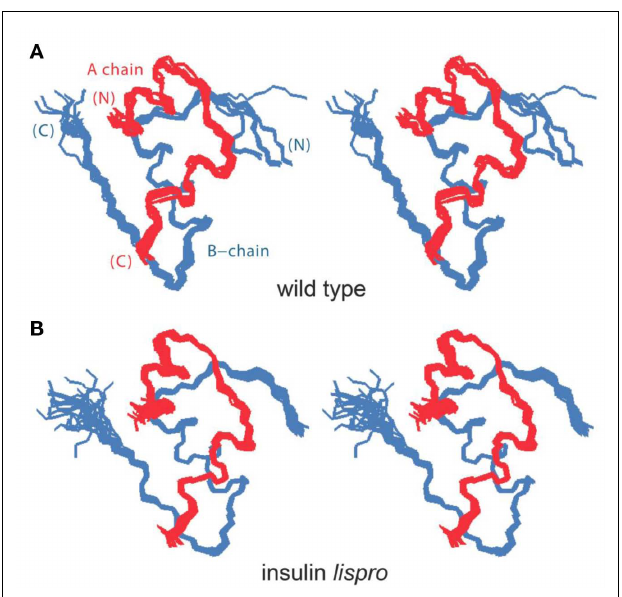
FIGURE 4 | NMR-derived structure of KP-insulin. (A) Reference collection of crystallographicT-state protomers (stereo pair).The structures (wild-type accession codes 1MSO, 4INS, 1APH, 1BPH, 1CPH, 1DPH, 1TRZ, 1TYL, 1TYM, 2INS, 1ZNI, 1LPH, 1G7A; KP-insulin accession code 2JMN) were aligned according to the main-chains within α -helices (residues A2–A7, A13–A19, and B9–B19).The A-chains are shown in red and B-chains in blue. (B) DG/RMD-derived ensemble of structures of KP-insulin as a monomer in solution.The color code and alignment scheme are as in (A)